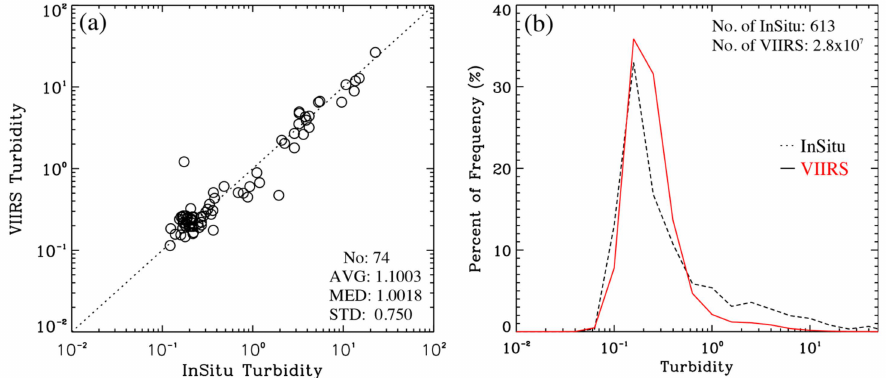
Figure 3. VIIRS–SNPP-derived water turbidity data (2012–2018) in the Great Lakes compared with the in situ turbidity measurements for ( a ) matchup comparison and ( b ) histogram